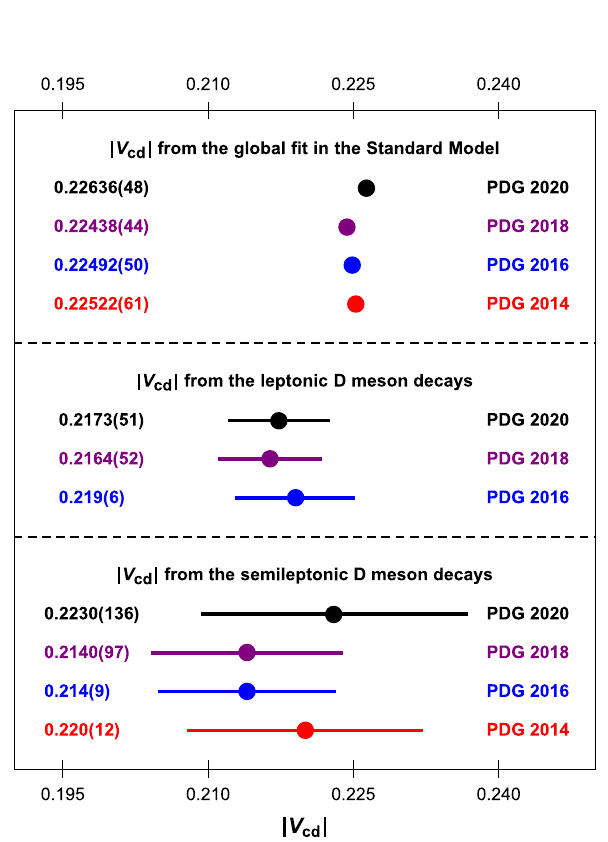
Fig. 3 The values of the CKM element | V cd | from